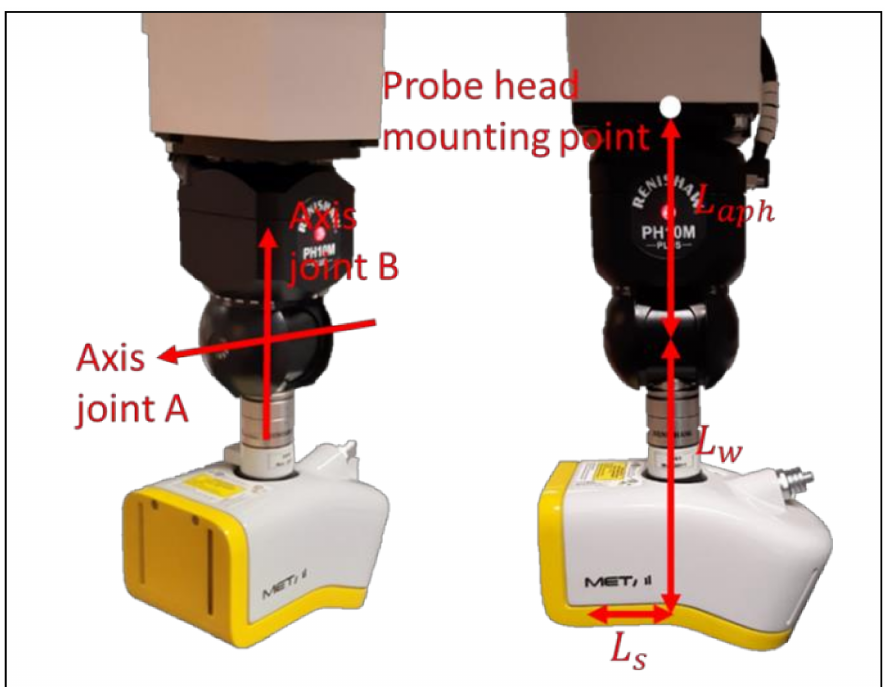
Figure 7. The articulating probe head with an LLS as probing system mounted on